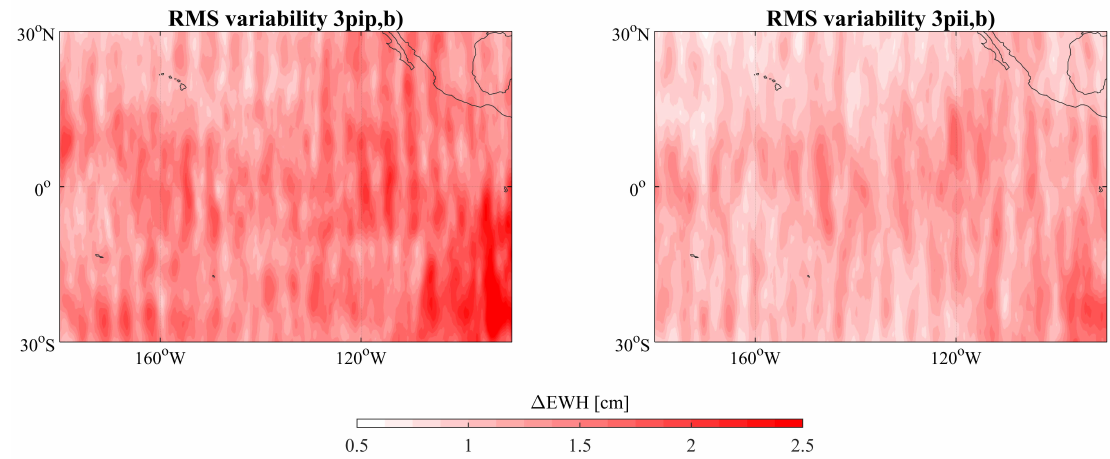
Figure 6. RMS variability over one year of triple-pair scenarios. Standard deviation computed from reference minus estimated solution until d / o 50. ( a ) RMS variability detail of triple-pair scenario 3pip,b. ( b ) RMS variability detail of triple-pair scenario 3pii,b.